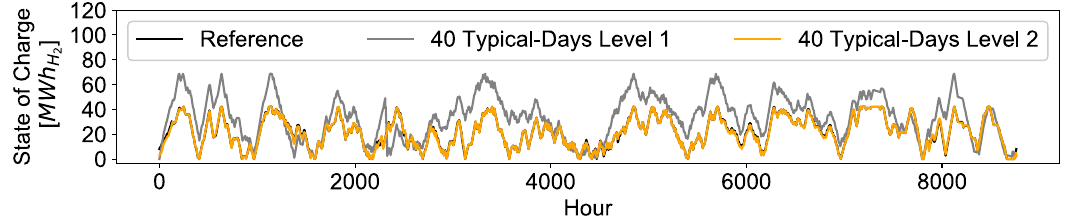
Figure 21. Hydrogen storage operation for the 2-Level Approach and the reference case.